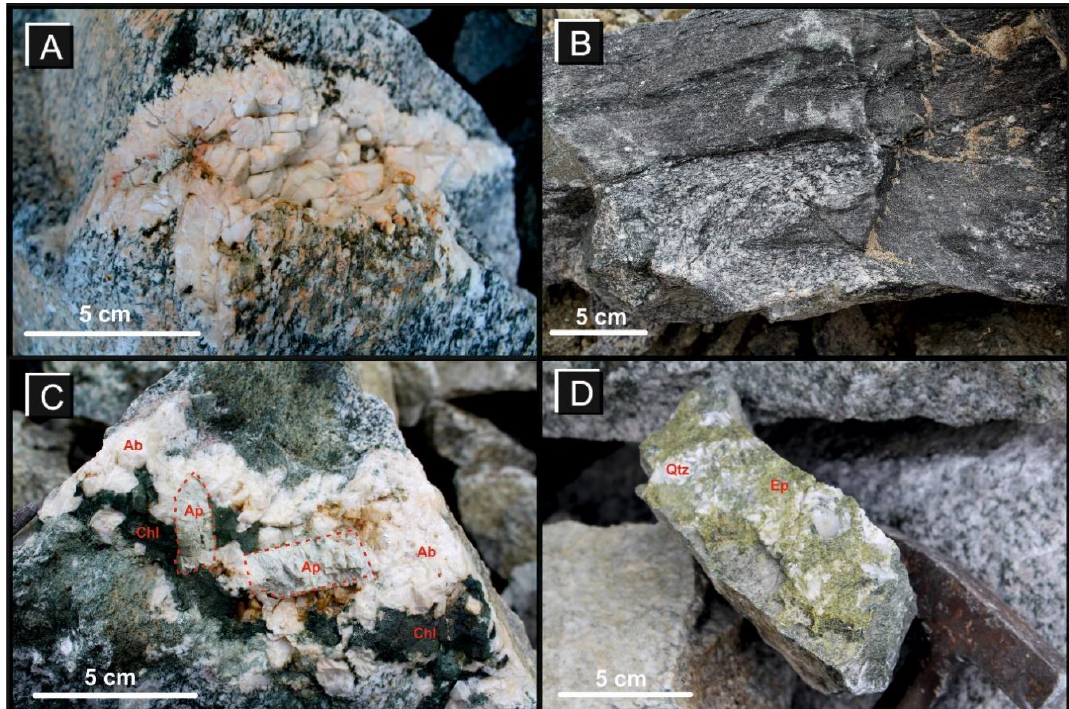
Figure 3. Photographs of the most common rock types in the investigated Kanarata quarry. ( A ) monzonite with an albite nest, ( B ) amphibolite xenolith within the contact zone, ( C ) an example of Alpine-type fissures, and ( D ) the second vein type with massive quartz and epidote. Ap = apatite, Chl = chlorite, Ab = albite, Ep = epidote, and Qtz = quartz.